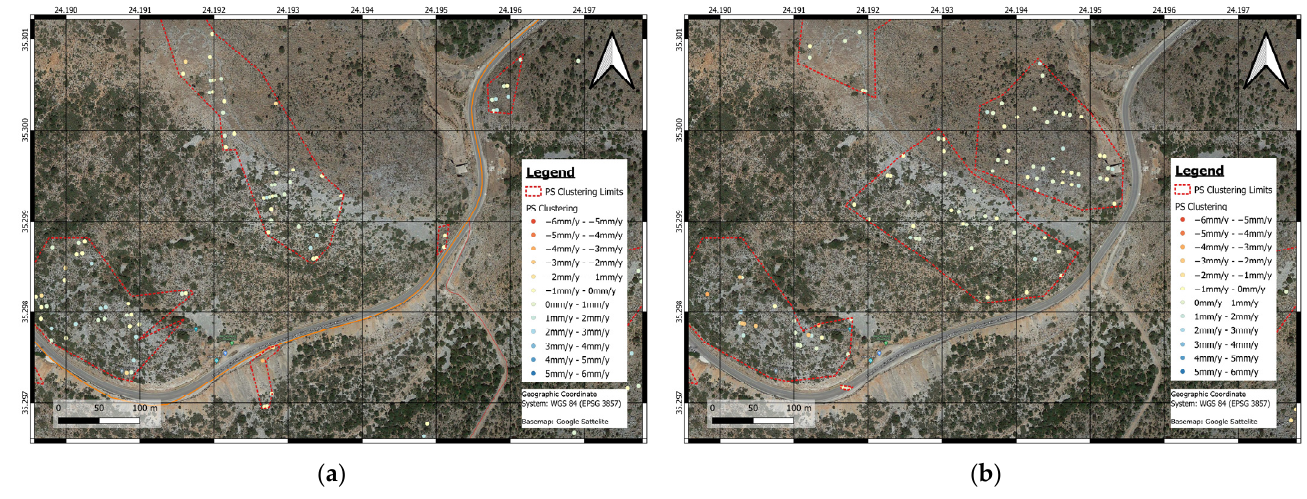
Figure 4. Identification of a slow-moving landslide on the road outside Askifou village [34] for the ( a ) ascending satellite pass and for the ( b ) descending satellite pass.